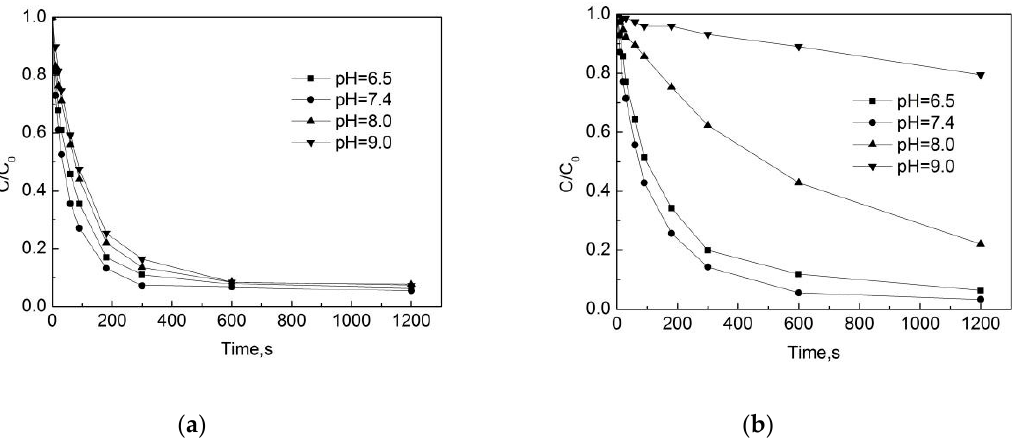
Figure 5. Degradation of OFL under di ff erent pH in ( a ) water distribution system; ( b ) deionized